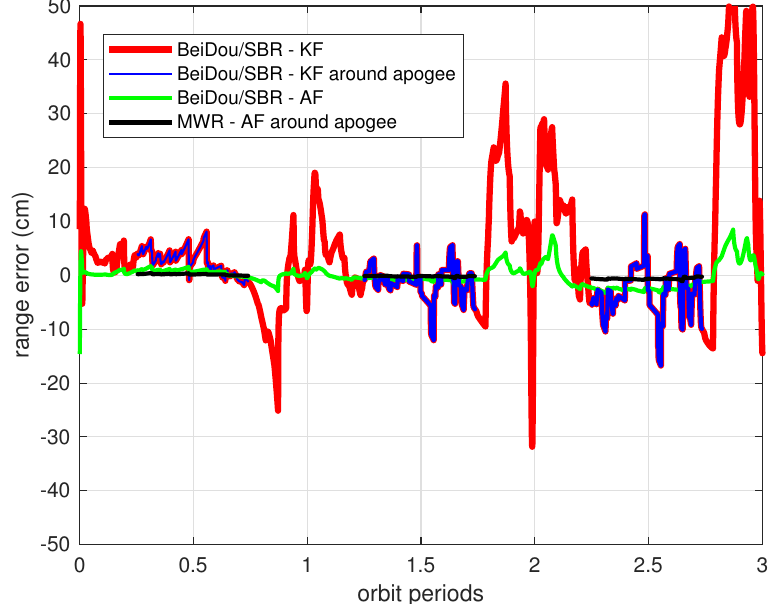
Figure 12. Relative range estimation errors from different payloads and filters. The red line shows the relative range estimation errors of BeiDou/SBR payload using the traditional Kalman filter algorithm (the same data as during apogee time in the blue lines); the green line represents the estimation errors of the BeiDou/SBR payload using the adaptive filter (AF); the black lines show the estimation errors of the MWR payload using the adaptive filter during apogee